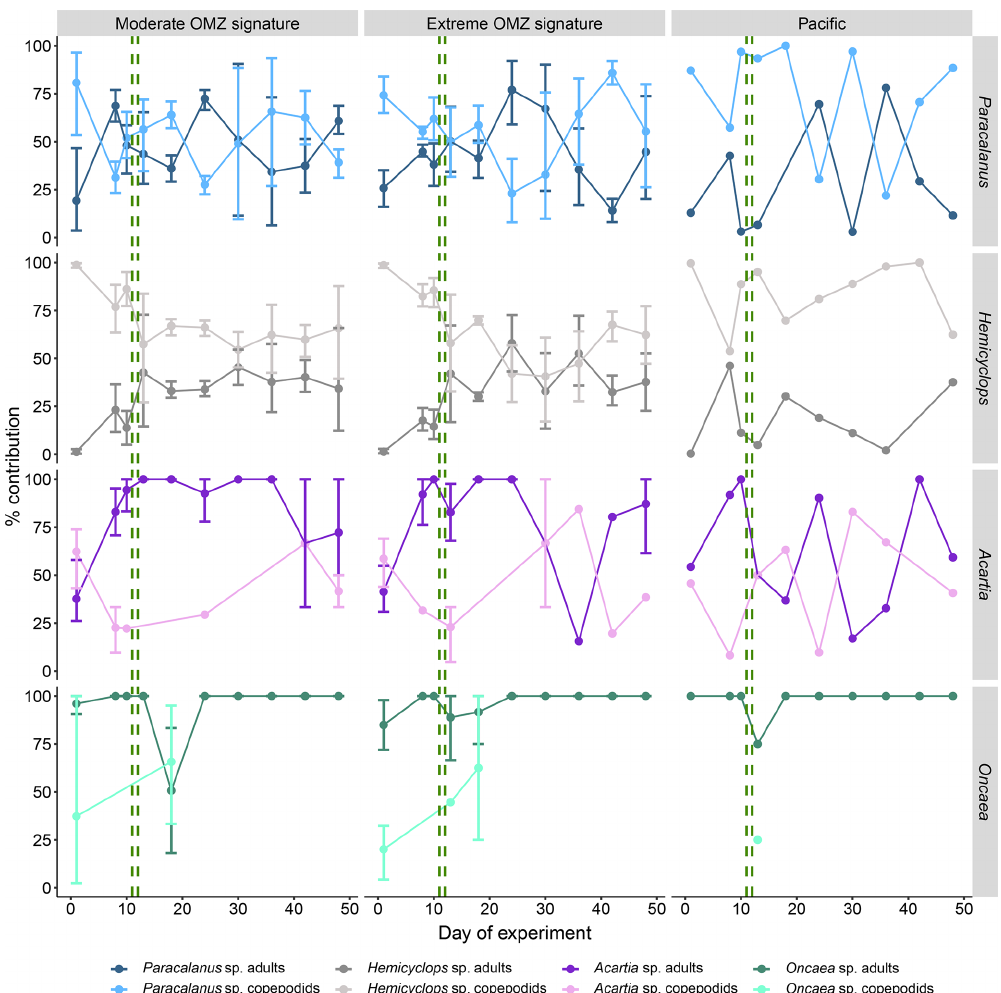
Figure 6. Temporal succession of developmental stages of dominant copepods (average percent contribution to total genus abundance with 95% confidence intervals). Adults comprise female and male copepods, and copepodids comprise stages CI–CV. The green vertical dashed lines indicate the days of OMZ water